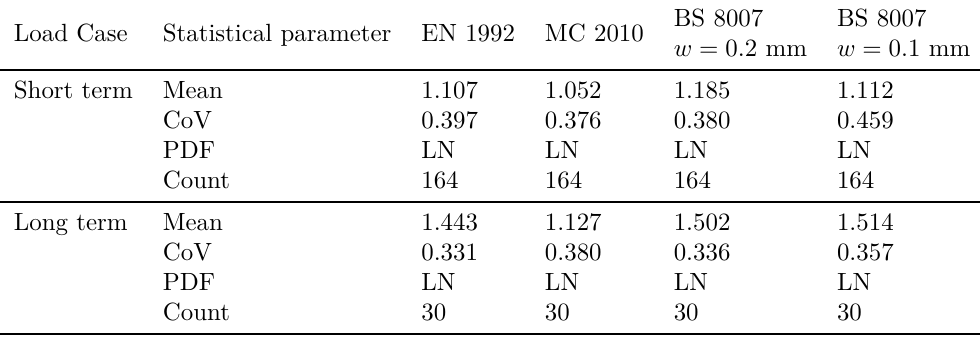
Table 5. Summary of statistical parameters of MF for flexural cracking